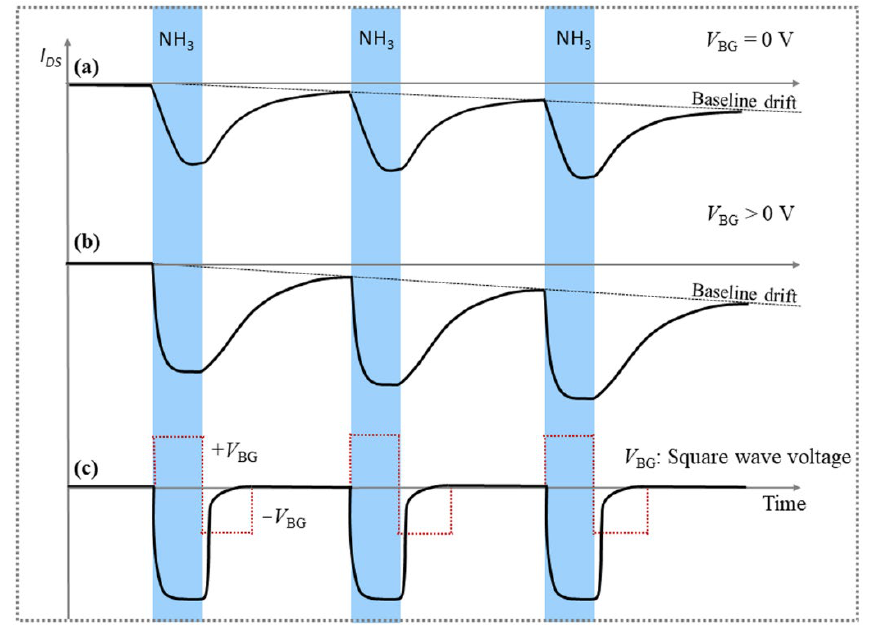
Figure 2. The schematic current response of the PPy/G FET sensor with time under different polarities of back-gate voltages for NH 3 detection. The blue rectangles indicate the NH 3 -on states: ( a ) When V BG = 0 V, the current response of the sensor was low and the sensor recovery was slow, with a current baseline drift. ( b ) When V BG > 0 V, the current response increased, but the sensor recovery became slower, with a larger baseline drift. ( c ) When the sensor was gated by a square wave voltage, the current response and the sensor recovery were promoted and accelerated by the positive and negative half cycles of the square wave voltage, respectively. The red dotted lines express the square wave voltage.